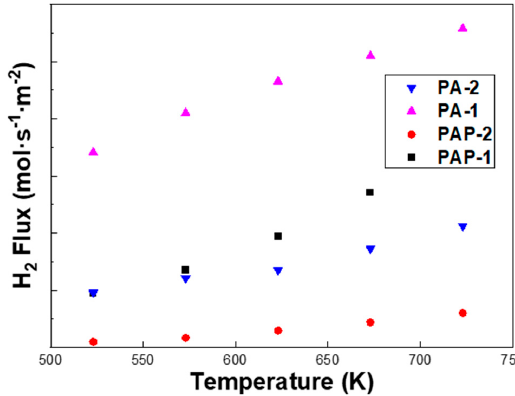
Figure 6. Temperature dependence of H 2 permeation flux ( Δ P H2 = 200 kPa) of PA-1, PA-2, PAP-1 and PAP-2.